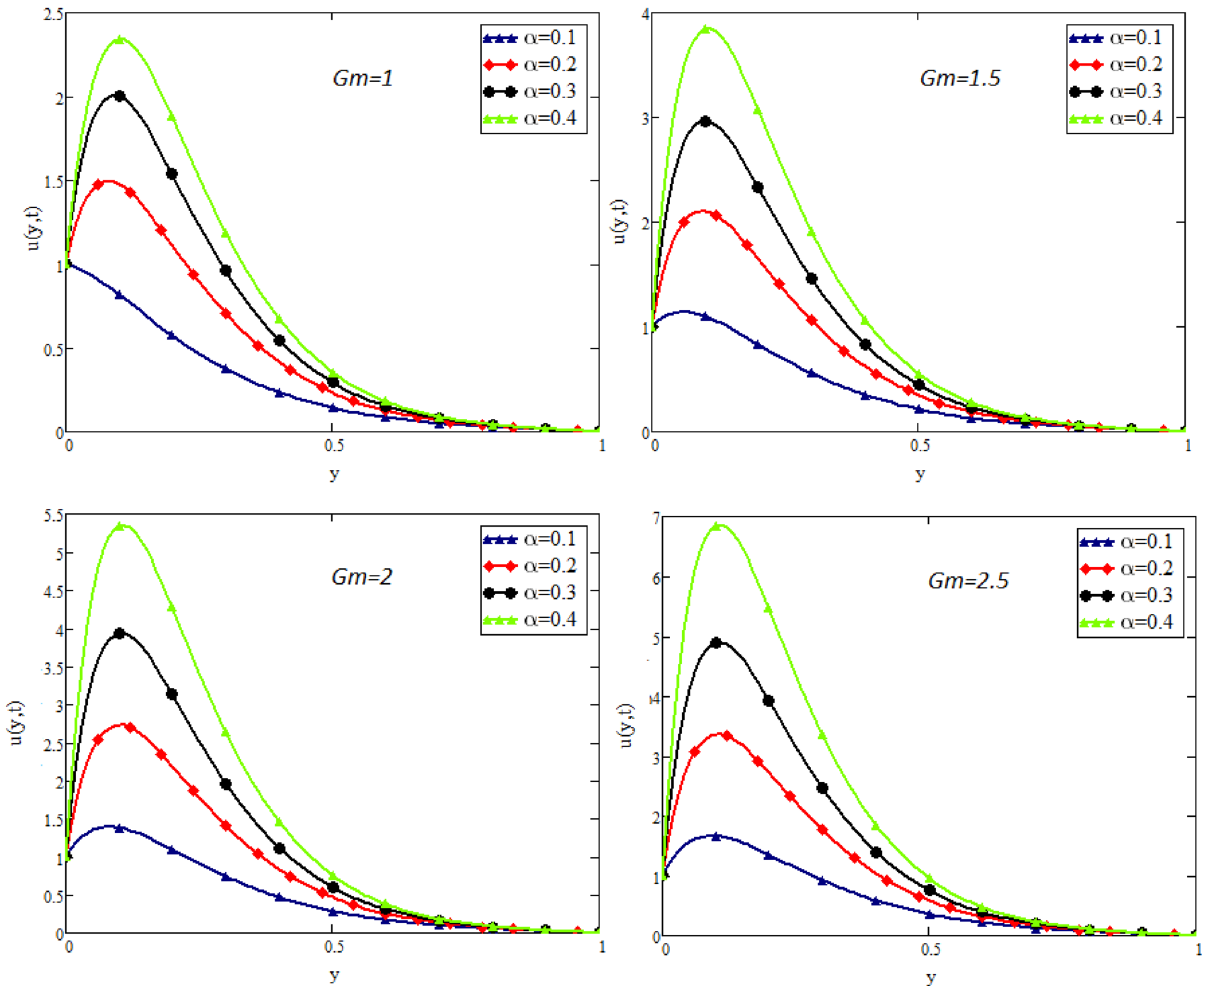
Figure 4. Impact of Gm on velocity distribution when t = 1 , Gr = 1.5 , Pr = 50 , Sc = 20 , β = 2 , and (cid:31) = 1